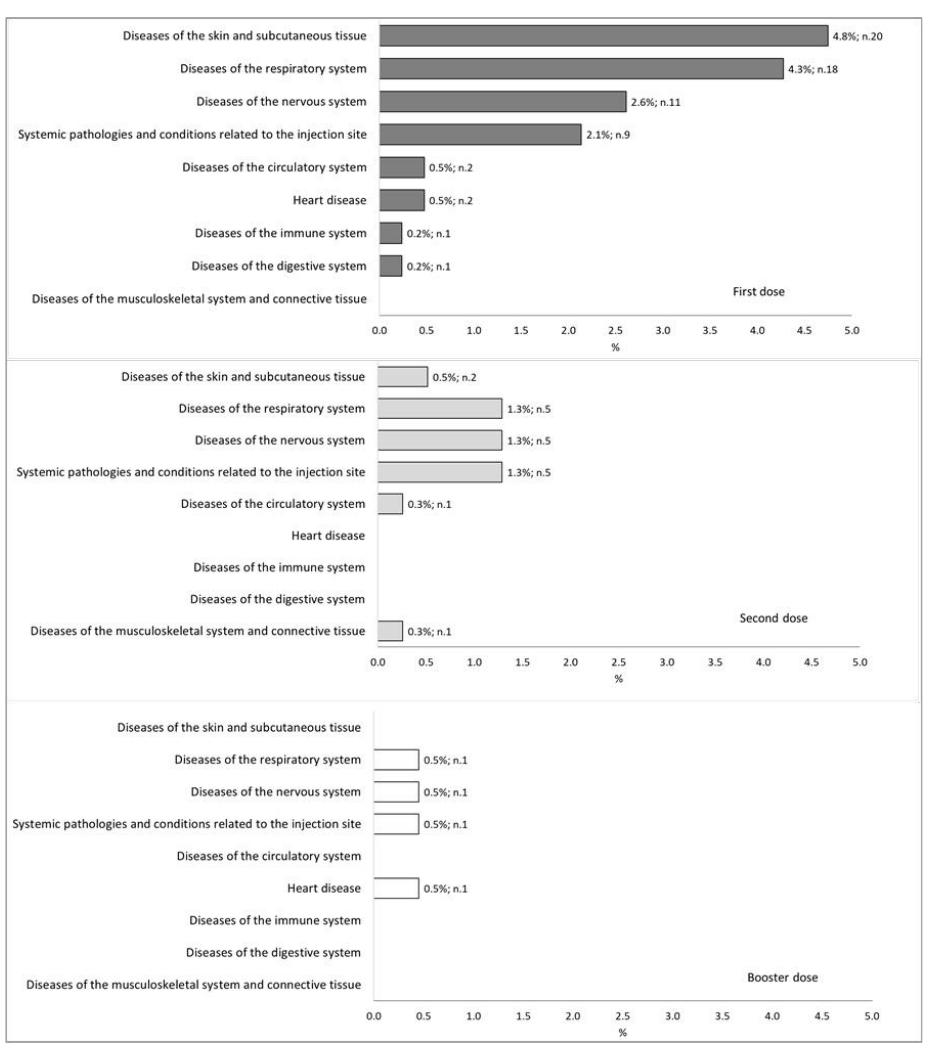
Figure 2. Distribution percentages of post-vaccination reactions classified through SOC classifica- tion, for each number of doses administered . for each number of doses